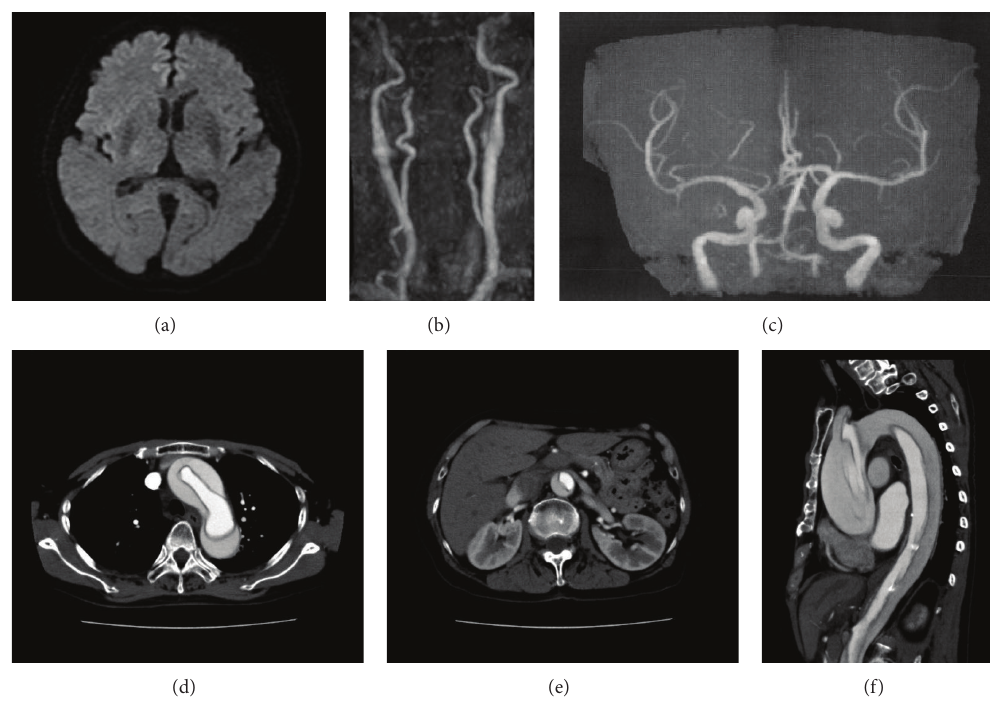
Figure 1: Axial head MRI-diffusion-weighted image (DWI) (a), carotid MR angiography (b), head MR angiography (c), axial chest to abdominal enhanced CT ((d), (e)), and sagittal view